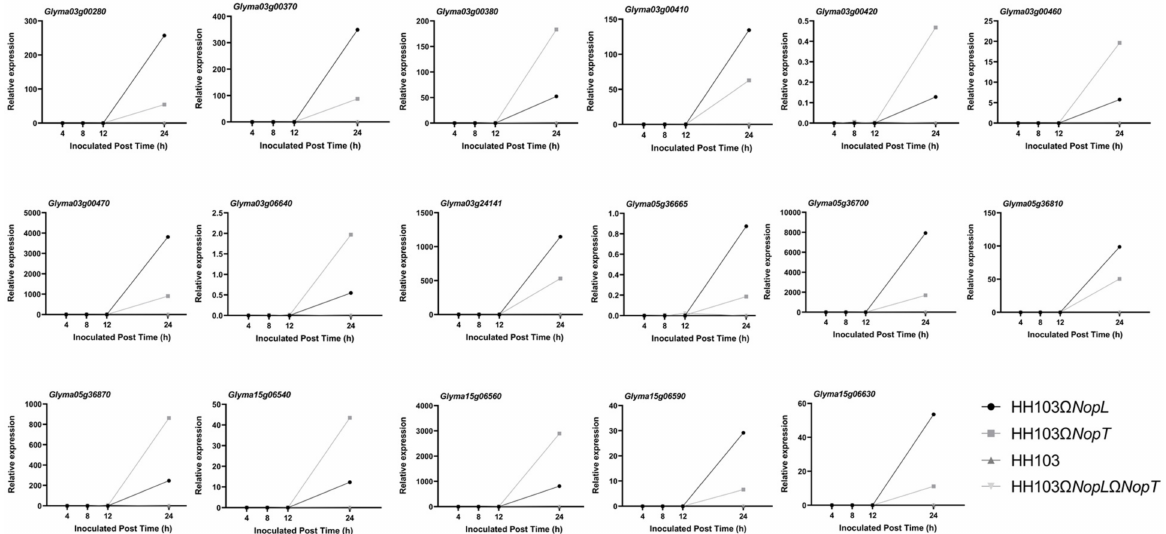
Figure 5. Relative expression levels of 17 candidate genes in ‘Suinong14 (cid:48) soybean roots independently inoculated with S. fredii HH103, S. fredii HH103 Ω NopL , HH103 Ω NopT, and HH103 Ω NopL Ω NopT . Non-inoculated plants were included as the control. The expression levels of target genes relative to the control samples at the indicated time points were calculated according to the 2 − ∆∆ CT method. Bars represent the mean ± standard error of three